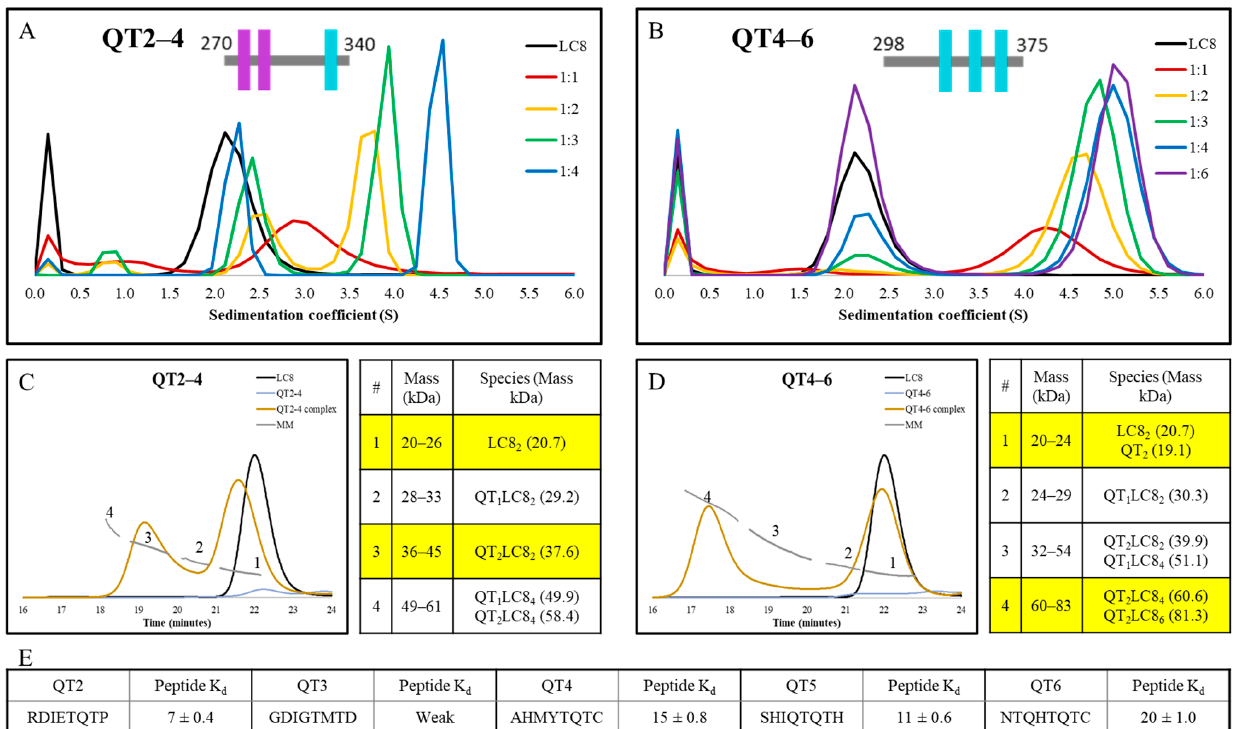
Figure 6. AUC, SEC-MALS, and peptide K d comparisons for the constructs QT2–4 and QT4–6. AUC titration of ( A ) QT2–4 (replotted data from Reardon et al. [29]) and ( B ) QT4–6. SEC-MALS chromatogram and mass key for ranges numbered as shown on the chromatogram for ( C ) QT2–4 and ( D ) QT4–6 as single proteins and in complex with LC8. LC8 alone trace is shown plotted with both proteins for reference. Highlighted regions of the mass key emphasize the major peaks seen in the SEC-MALS traces of the mixture. ( E ) Measured K d values for peptides representing the five binding sites [10] represented across the two analyzed constructs.